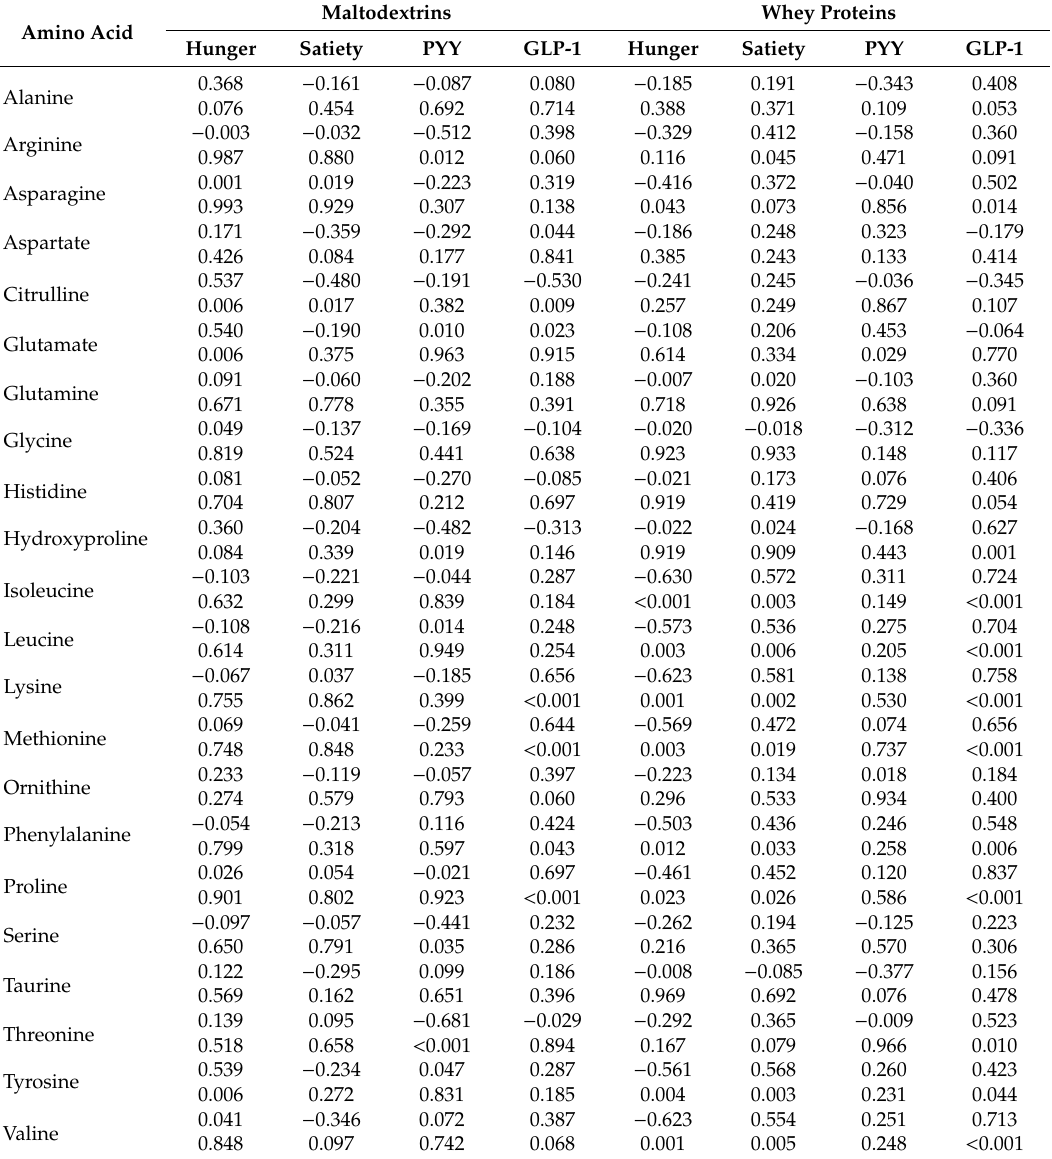
Table 2. Correlations of circulating levels of amino acids with hunger, satiety, PYY, and GLP-1 before and after ingestion of a beverage containing maltodextrins or whey proteins in obese subjects (all data: T0, T60, and